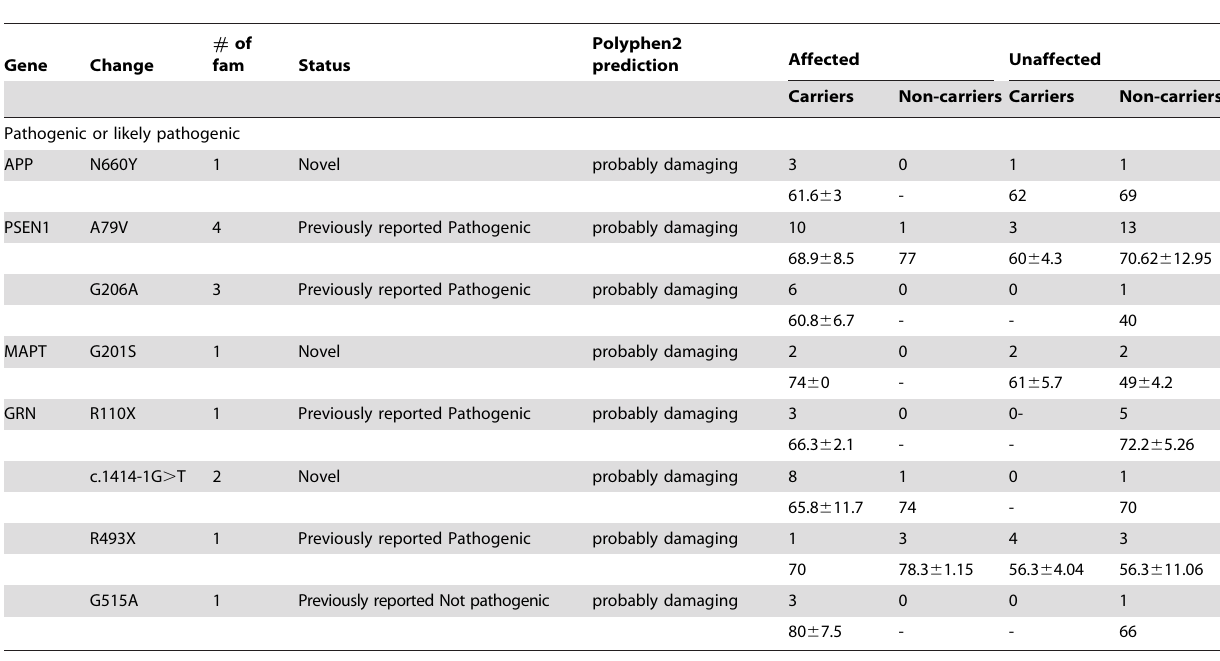
Table 4. List of the pathogenic and likely pathogenic non-synonymous, splice site and nonsense sequence variants identified.